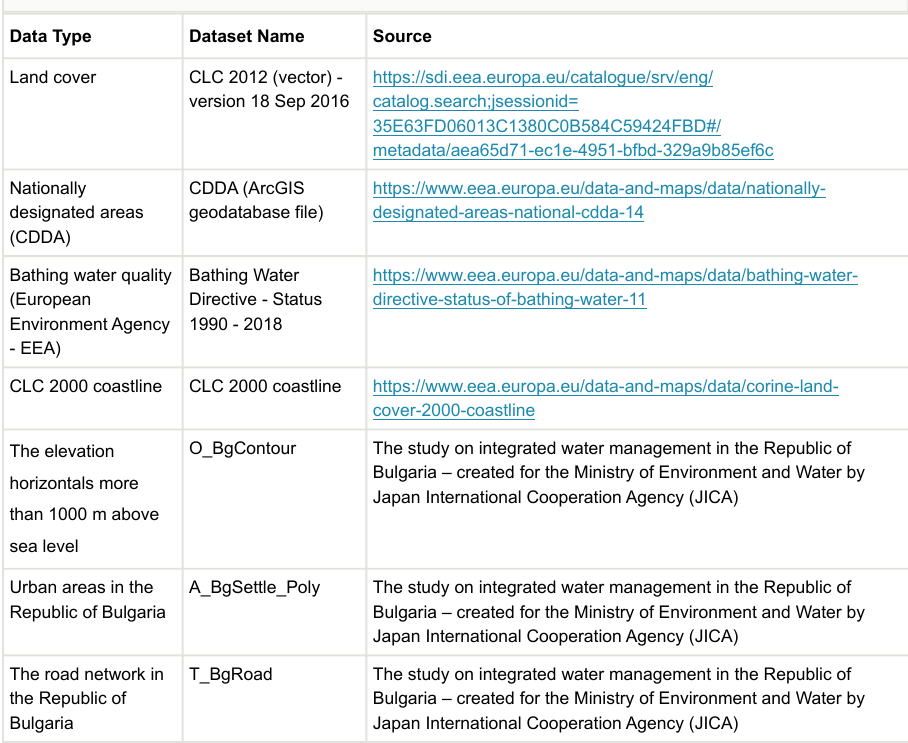
Table 1. Input data for the adaptation of the model.